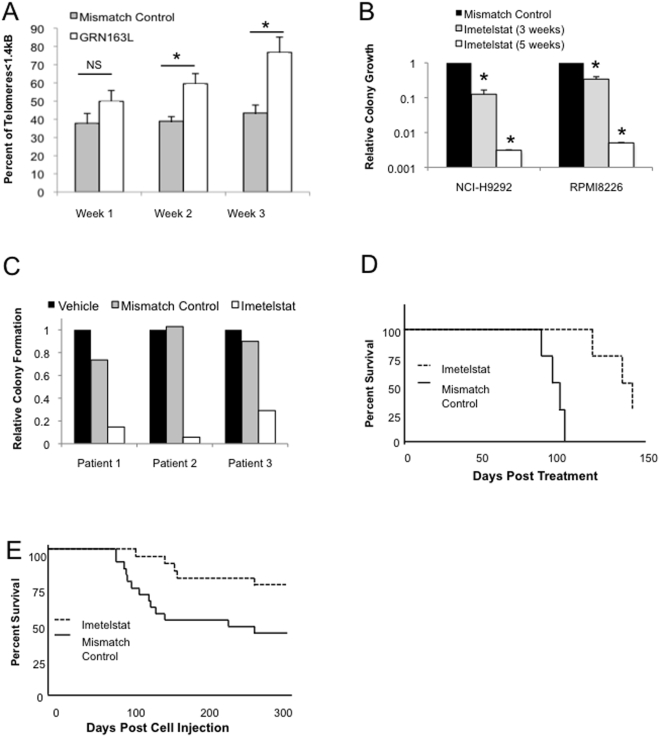
Prolonged telomerase inhibition decreases MM CSC telomere length and clonogenic potential.(A) Percentage of telomeres less than 1.4 kb as determined by STELA after 1, 2, or 3 weeks with mismatch control oligonucleotide or imetelstat (*p-value <0.05 and NS; not significant). (B) Relative clonogenic growth of CD138neg NCI-H929 and RPMI8226 cells after 3 and 5 weeks of treatment with mismatch control oligonucleotide or imetelstat (1 uM). (C) Relative clonogenic recovery of CD138neg cells isolated from primary clinical specimens following 3 weeks of treatment with vehicle, mismatch control oligonucleotide or imetelstat (1 uM). (D) Survival of NOD/SCID mice injected with NCI-H929 cells then treated with imetelstat (solid line) or mismatch control oligonucleotide (dashed line) for two weeks in vivo (p<0.01, n = 8,). (E) Survival of NOD/SCID mice after injection with NCI-H929 cells following in vitro treatment with imetelstat (solid line) or mismatch control oligonucleotide (dashed line) for two weeks (P<0.001, n = 20 per group).